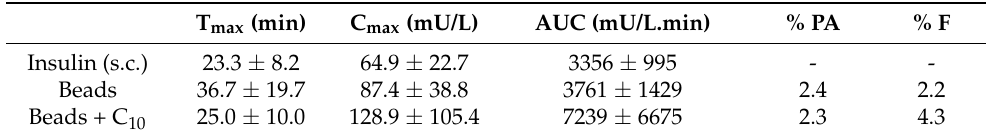
Table 5. PK-PD parameters from i.j. instillations with prototype insulin-dWPI beads (mean ± SD, n = 4 − 6). Insulin + C 10 (100 mM) is historical data and, as such, the % F and % PA were calculated using a different s.c. dataset